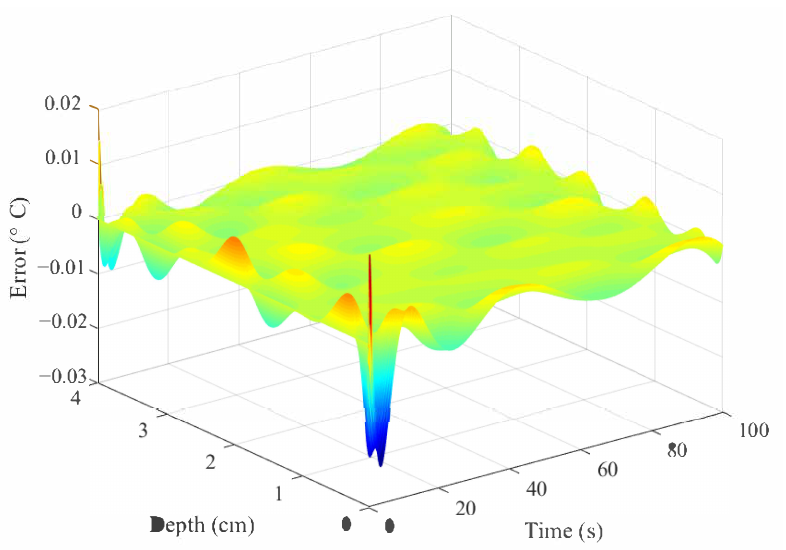
Figure 5. Comparison between the reduced-order model and original model for the global tempera- ture distribution.